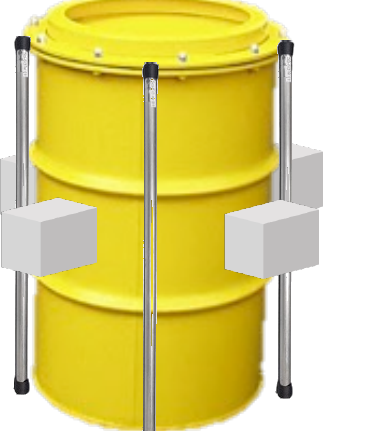
Fig. 12. Possible arrangement of the SiLiF and SciFi detectors on the radwaste